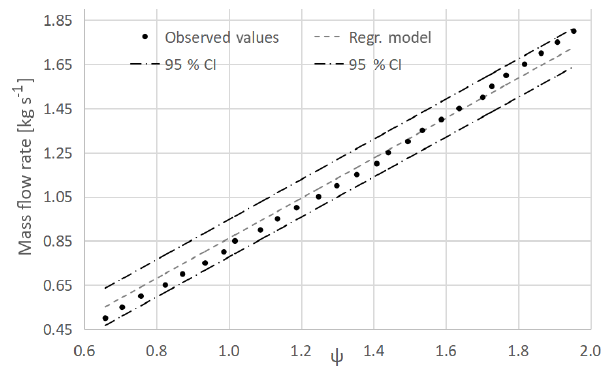
Figure 29. Mach number contour map, P-G V-Cone, β ≈ 0 . 533.